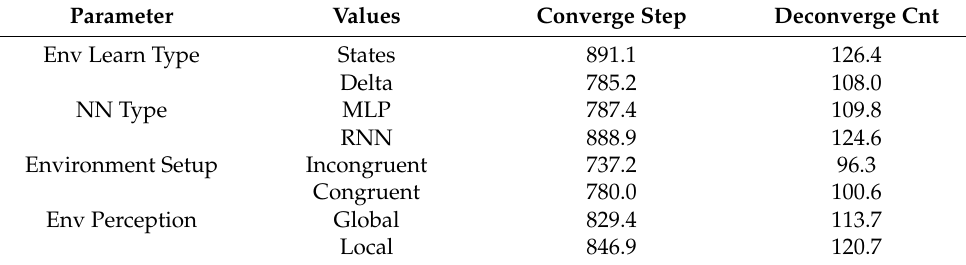
Table 3. Parameter